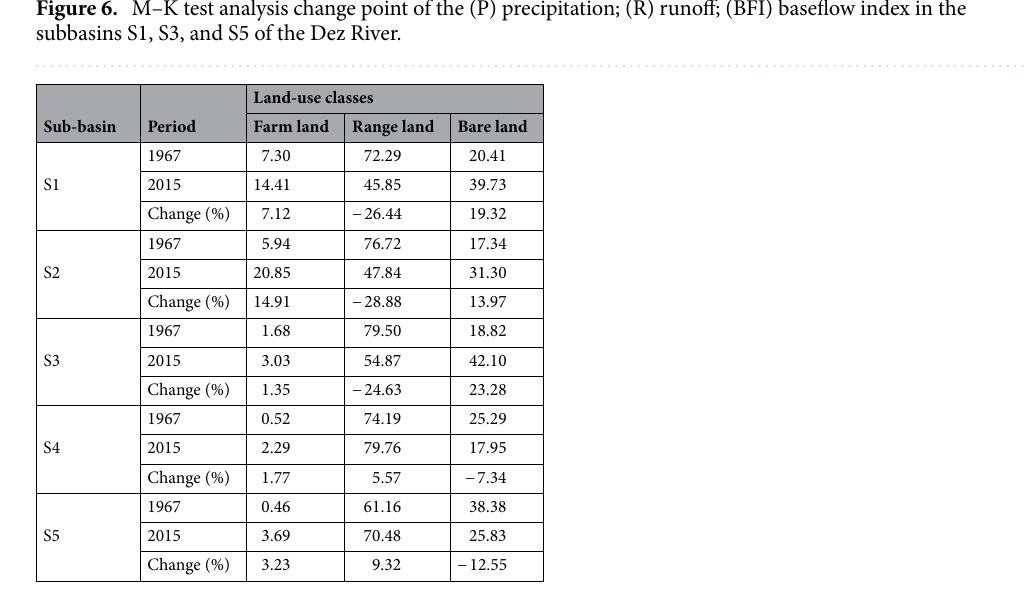
Table 6. Percentage of land-use changes for sub-basins from 1967 to